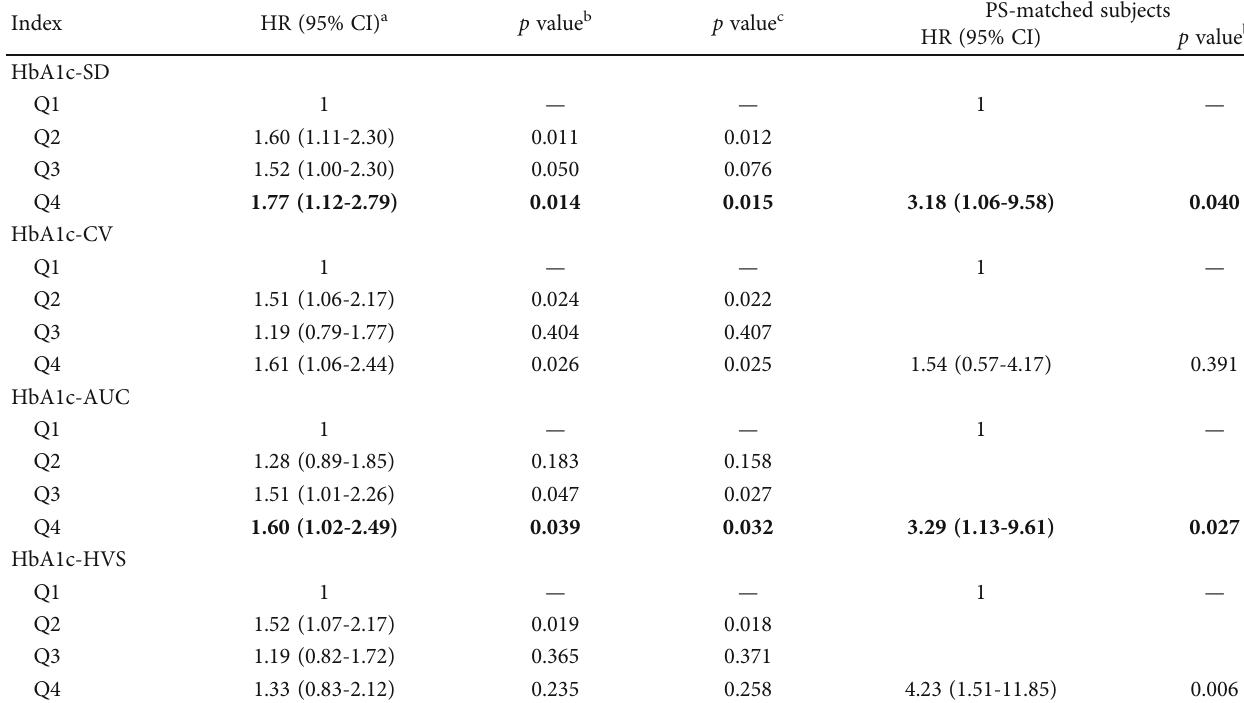
Table 2: Association of the risk of microalbuminuria with visit-to-visit variability of HbA1c, measured as 4 indices using a Cox proportional hazards